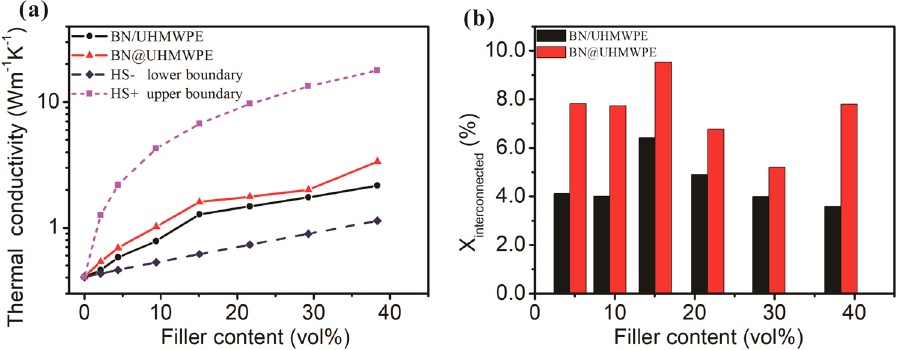
Figure 5: ( a ) Comparison between experimental data of the composites and HS model and ( b ) interconnectivity of the fi ller as a function of fi ller fraction.